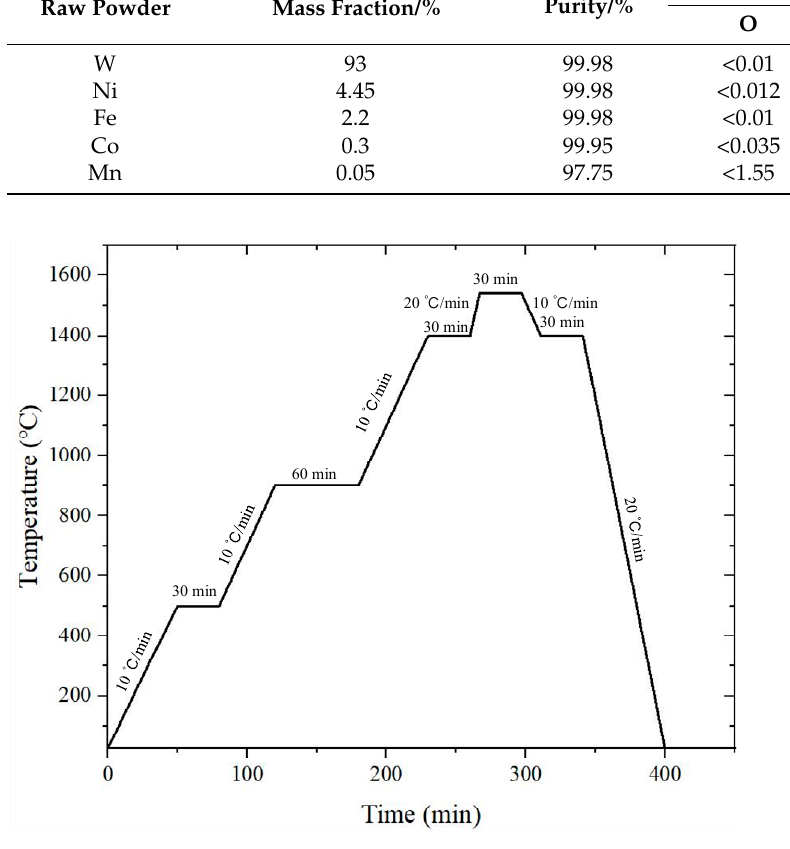
Figure 1. Liquid-phase sintering temperature and time curve.